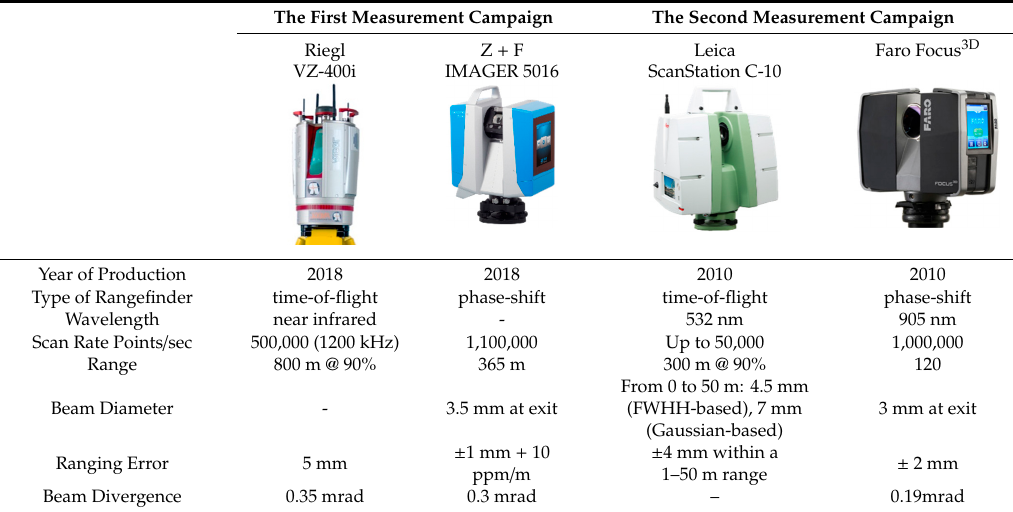
Figure 3. Part of the old historical building—real photo on the left, point cloud on the right.